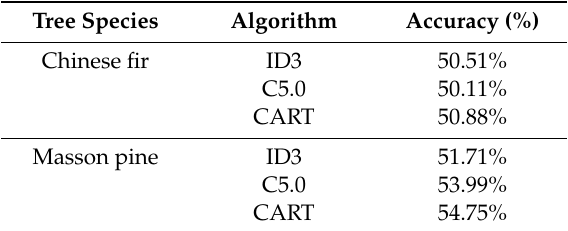
Table 7. Comparison results of three decision tree models.